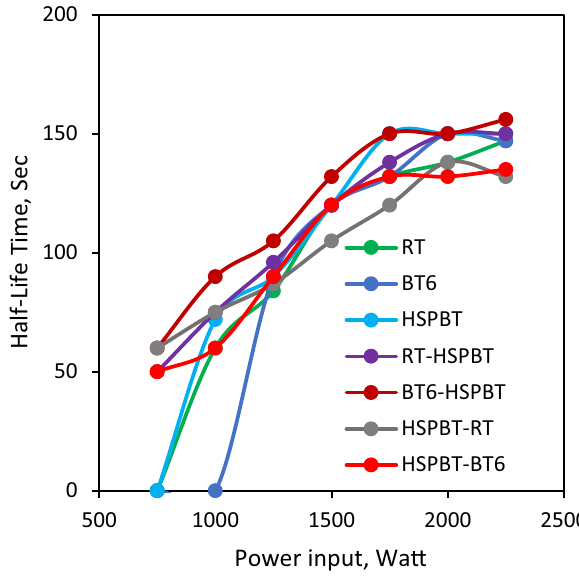
Fig. 6 Half-life time of an aqueous foam as a function of power for different impeller